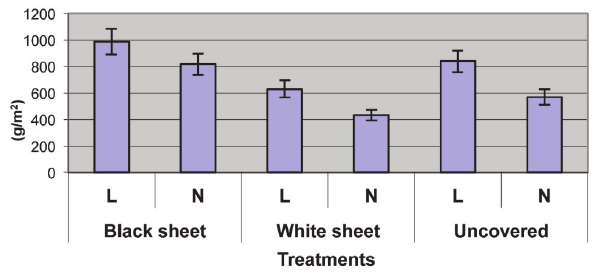
Figure 4. Total fresh biomass yield (g/m 2 ) during the vegetation